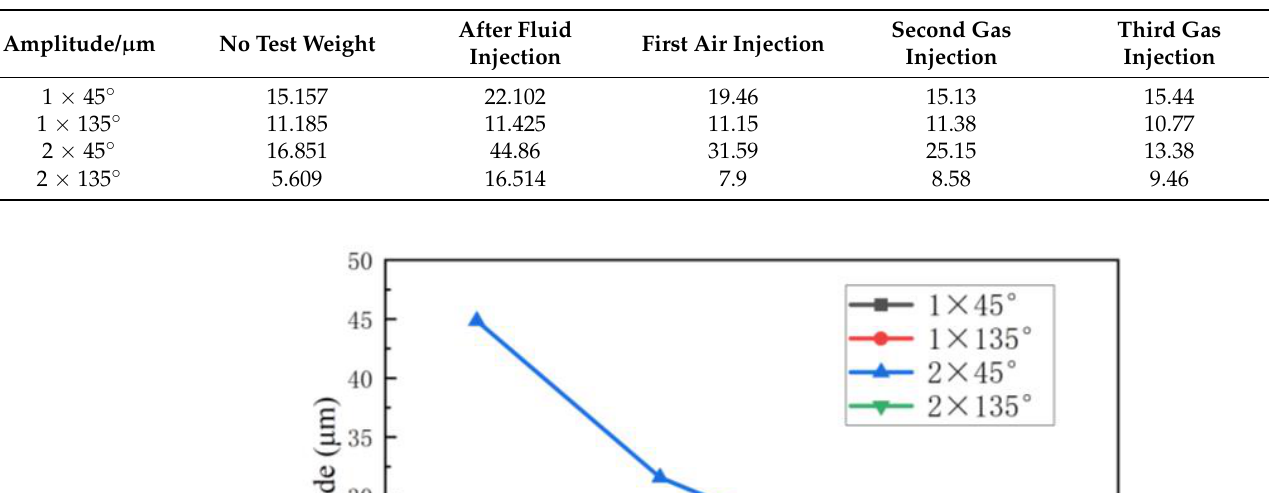
Table 3. Amplitude of each measurement point at 600 rpm.